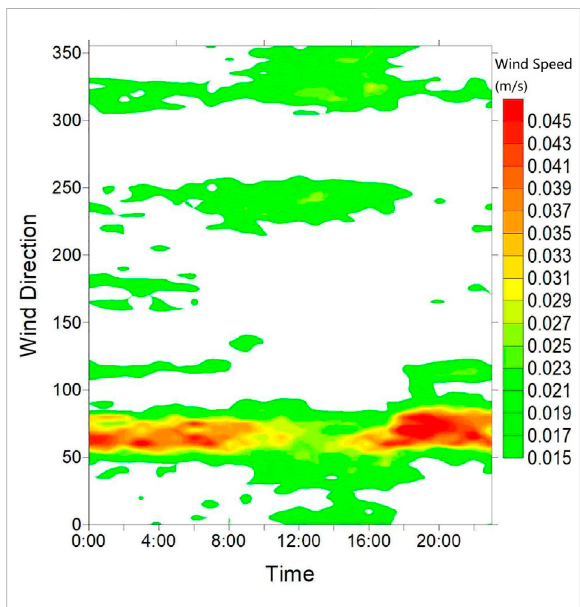
FIGURE 4 Diurnal variation of wind direction in east side of the Yangtze